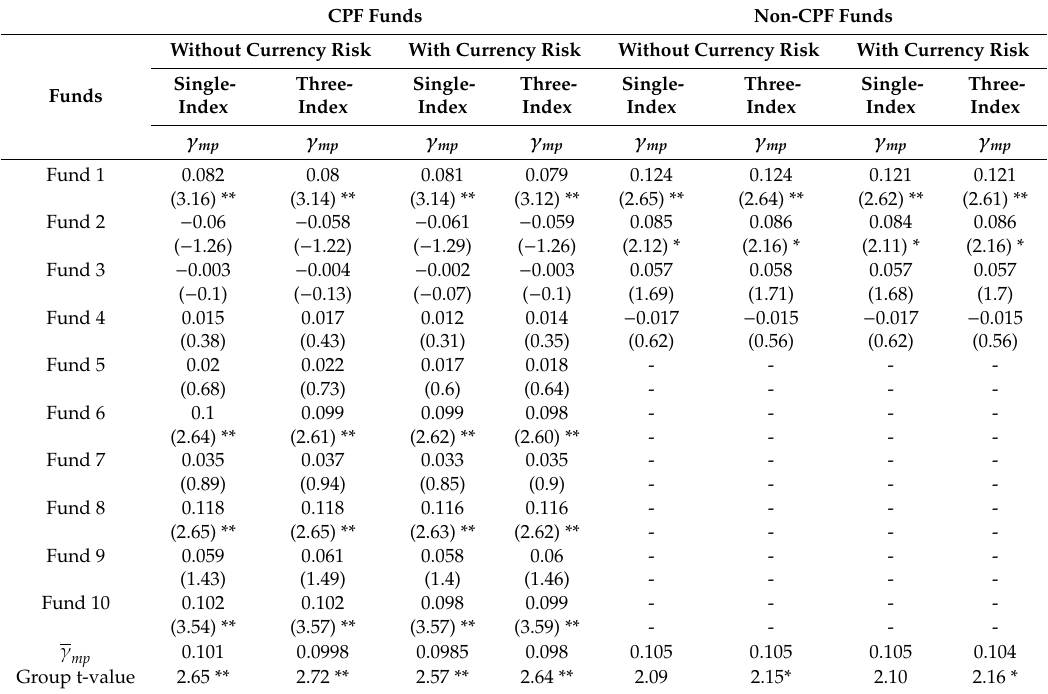
Table 7. Volatility-timing coe ffi cients for Asian ex-Japan equity funds under CPF Investment Scheme.